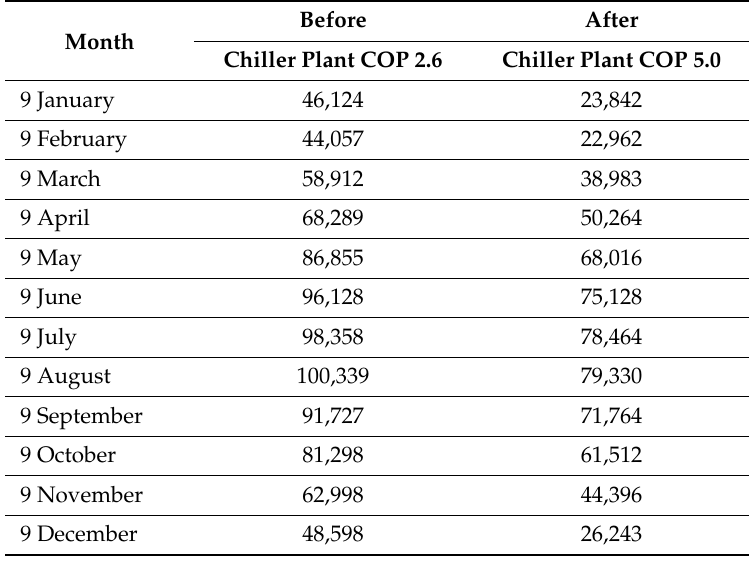
Table 10. Cooling electricity consumptions before and after the upgrade.